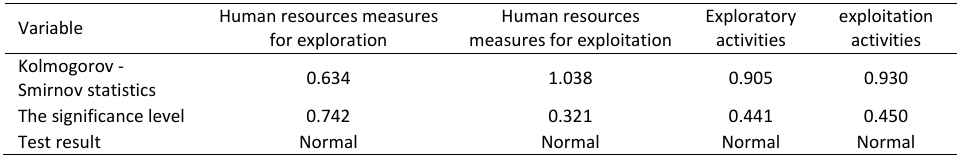
Table 2: Normality of variables (Kolmogorov ‐ Smirnov test) Table 2. Normality of variables (Kolmogorov - Smirnov